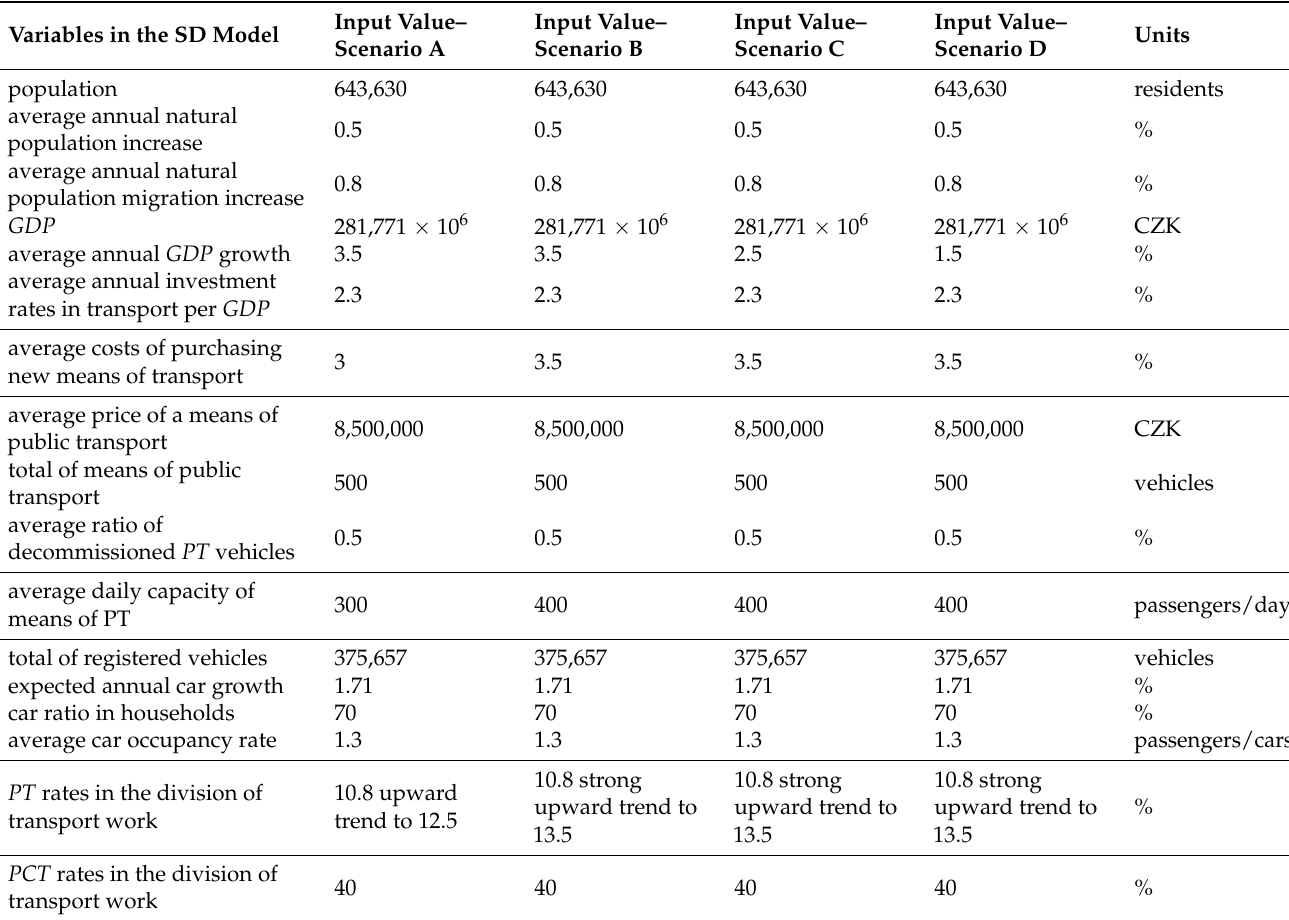
Table 2. Input model values for calculating supply and demand ratios for transport